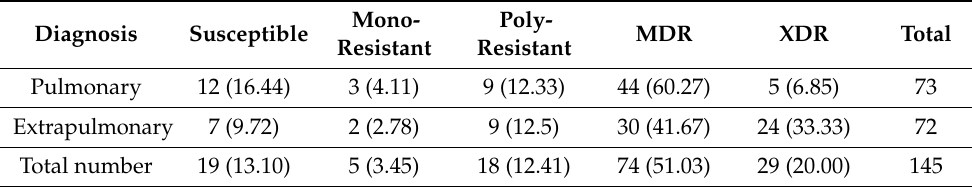
Table 2. Characterization of drug susceptibility of M. tuberculosis from different localizations, n (%). Mono- Diagnosis Susceptible